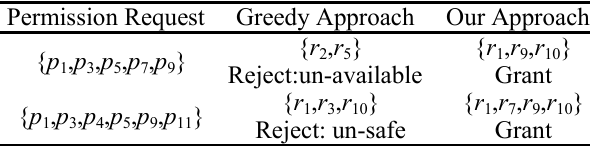
Table 1. Comparison greedy approach with